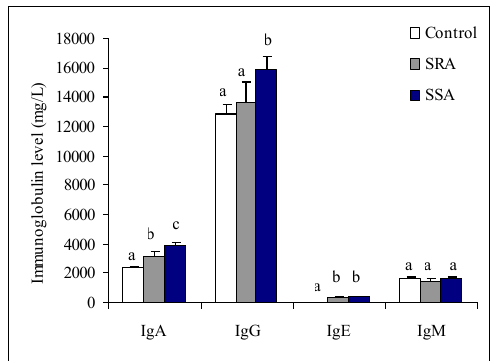
Fig. (1): Immunoglobulins level among SSA (n=28) and SRA (n=27) patients. Values are (mean ± SEM). Non-identical superscripts (a, b, c) considered significant, P<0.05 analyzed by ANOVA.